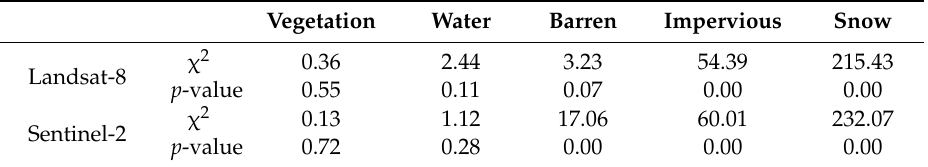
Figure 7. Average cloud detection accuracy obtained using FMASK and CECD for typical surface-cover types. ( a ) Average accuracy of the cloud detection for Landsat-8 imagery. ( b ) Average accuracy of the cloud detection for Sentinel-2 imagery. Noted: F. M., F-Measure; P. C., producer’s accuracy for cloud; U. C., user’s accuracy for cloud. Table 4. McNemar’s test for the di ff erence between the results for the FMASK and CECD cloud masks for specific